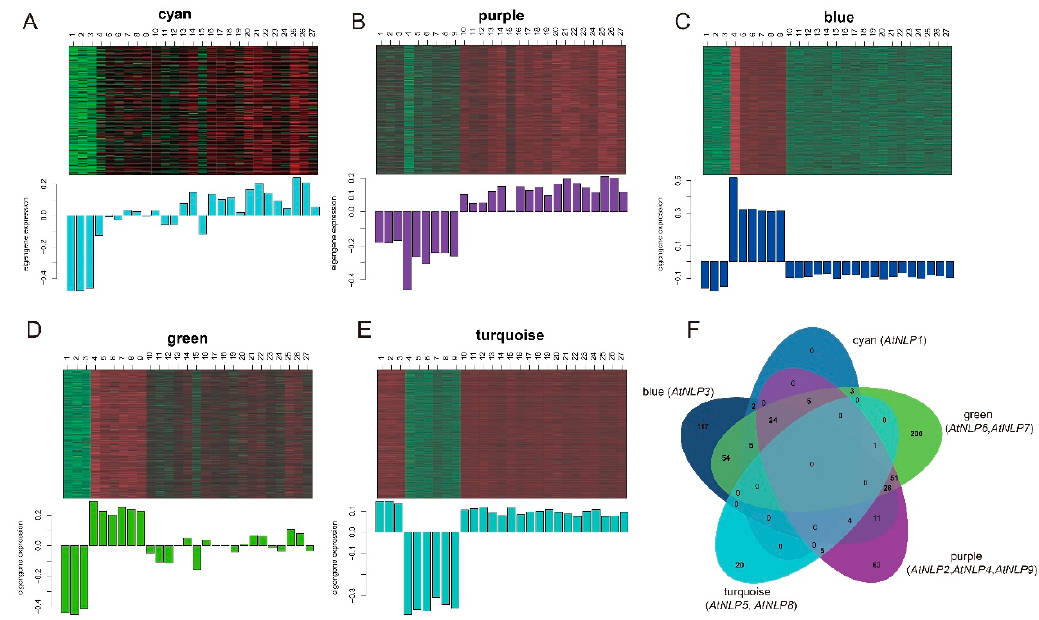
Figure 4. Modules containing AtNLP genes correspond to functional subdivisions of the N-starvation datasets. ( A ) Cyan module with AtNLP 1. ( B ) Purple module with AtNLP 2, AtNLP 4, and AtNLP 9. ( C ) Blue module with AtNLP 3. ( D ) Green module with AtNLP 6 and AtNLP 7. ( E ) Turquoise module with AtNLP 5 and AtNLP 8. ( F ) Venn diagram of enriched gene ontology terms for each module at the biological process level. The sample accessions above the heatmap represent each time point with three replications seen in Varala, et al. [29], 5 min (1–3), 10 min (4–6), 15 min (7–9), 20 min (10–12), 30